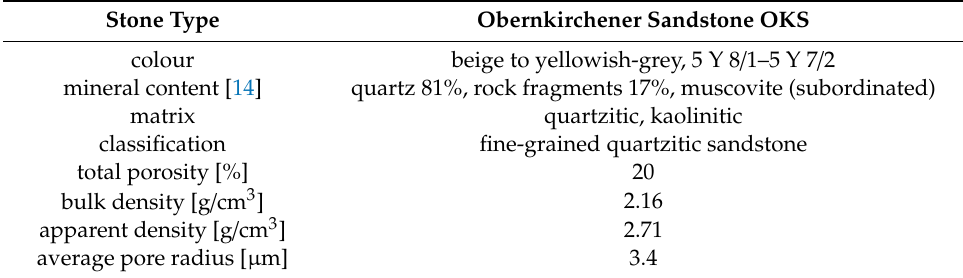
Table 1. Petrographic and petrophysical properties of Obernkirchener